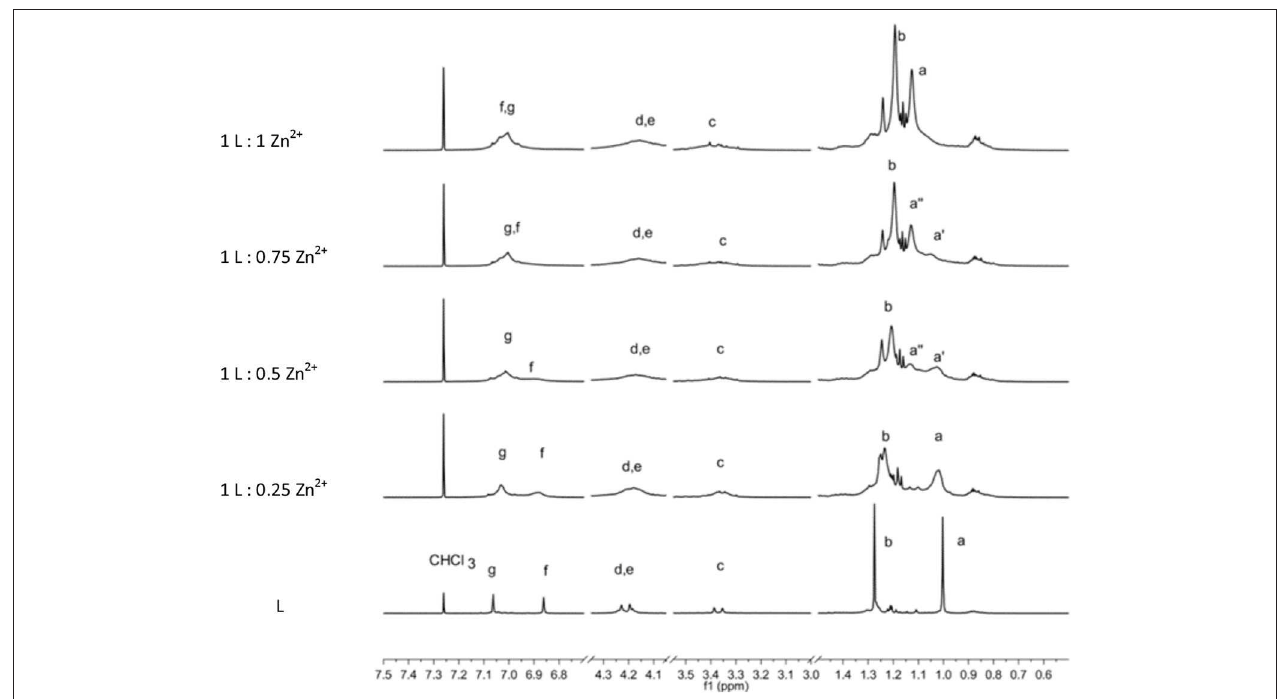
FIGURE 4 | 1 H-NMR spectrum sequence of titration of L by Zn 2 + ions. The bottom spectra of L are scaled by a factor of 0.2.